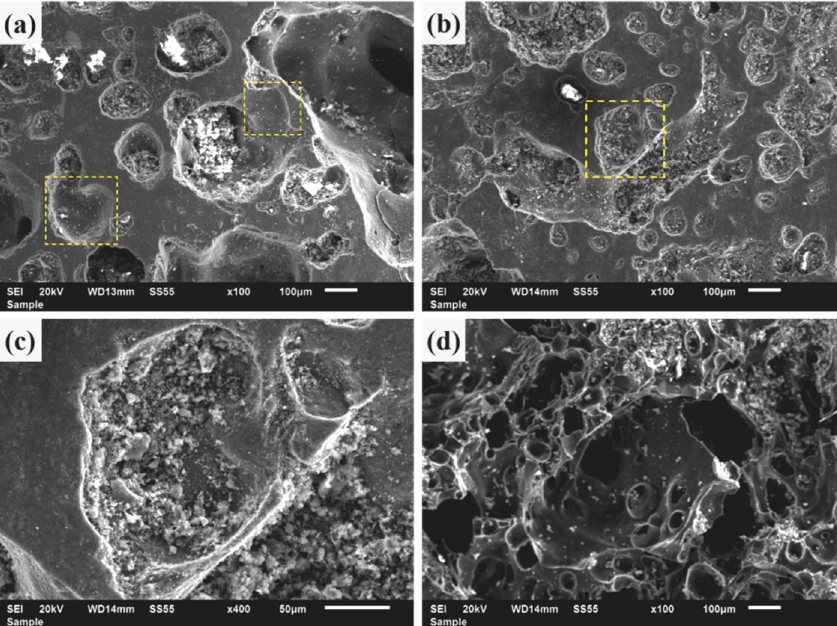
Figure 3. Micromorphology of CO 2 and coke melting loss at different times. ( a ) 0 h; ( b ) 1 h; ( c ) partial enlargement of ( b ); ( d ) 3 h.